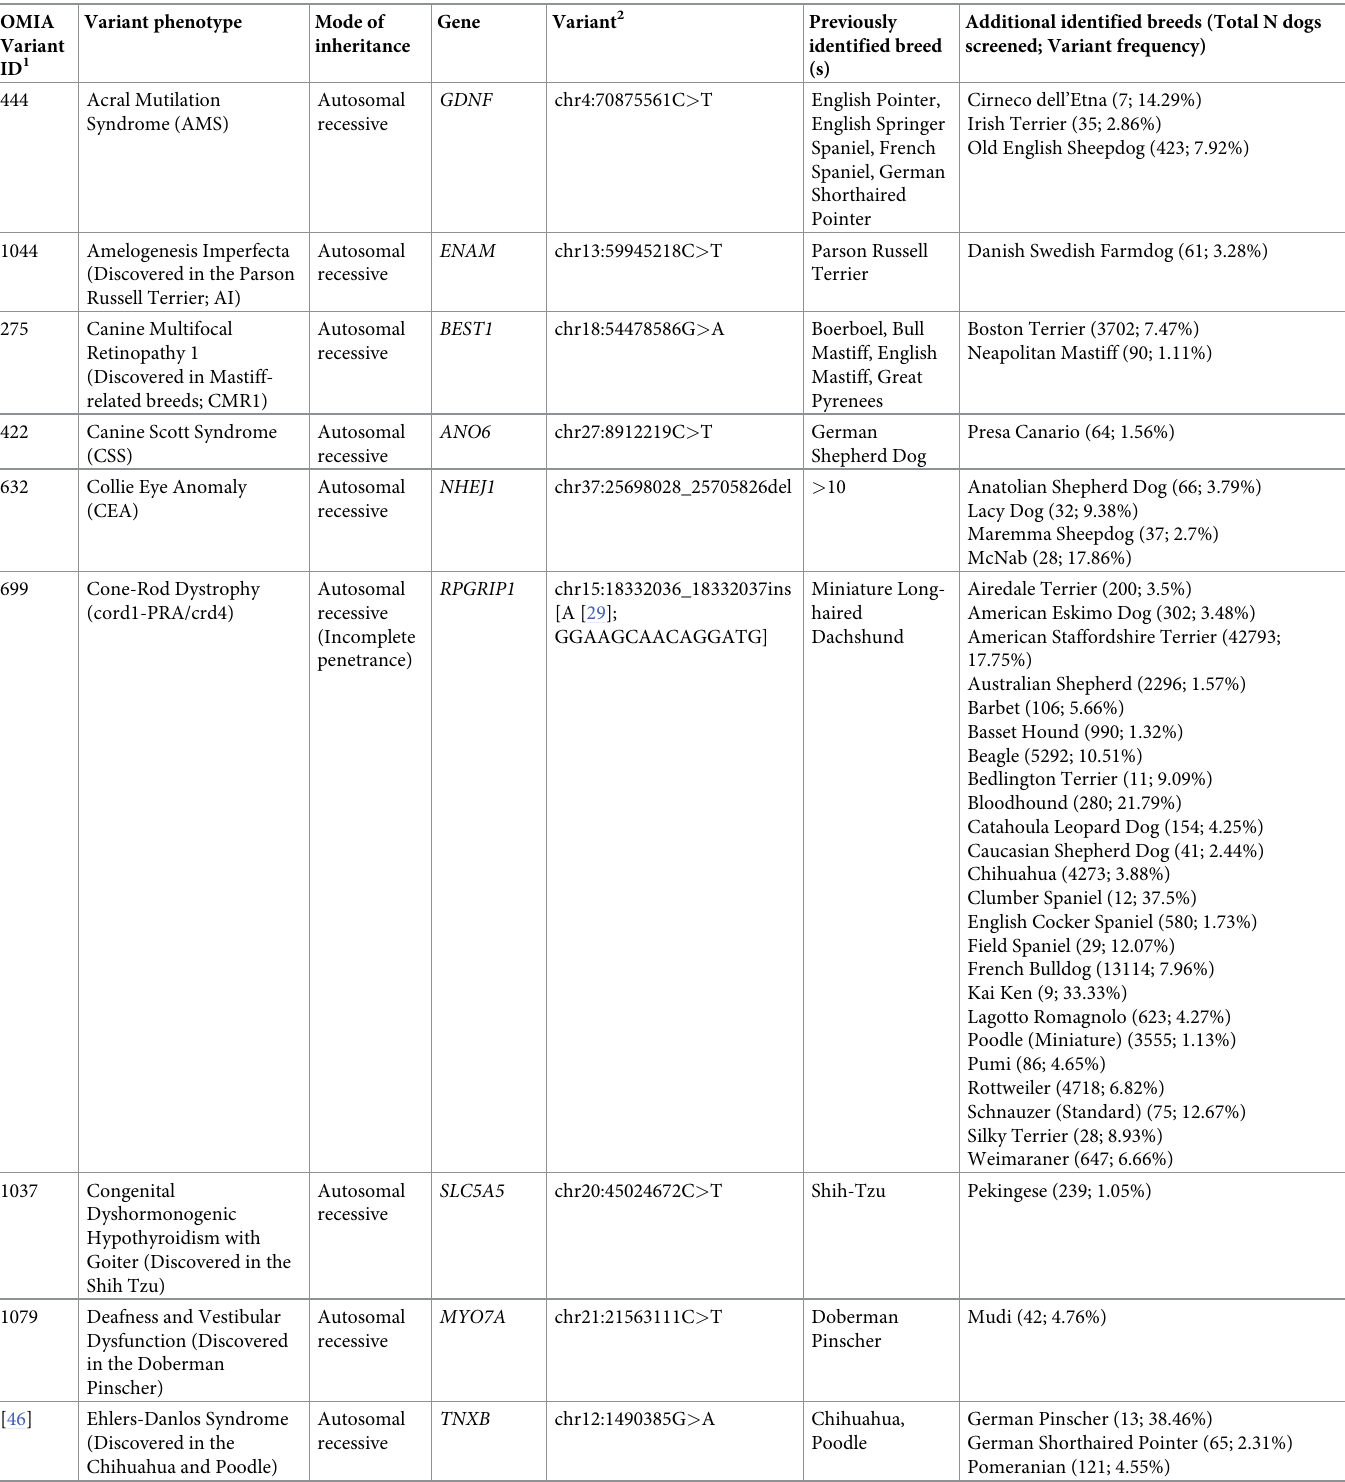
Table 2. Disease-associated variants found in additional breeds at an allele frequency �